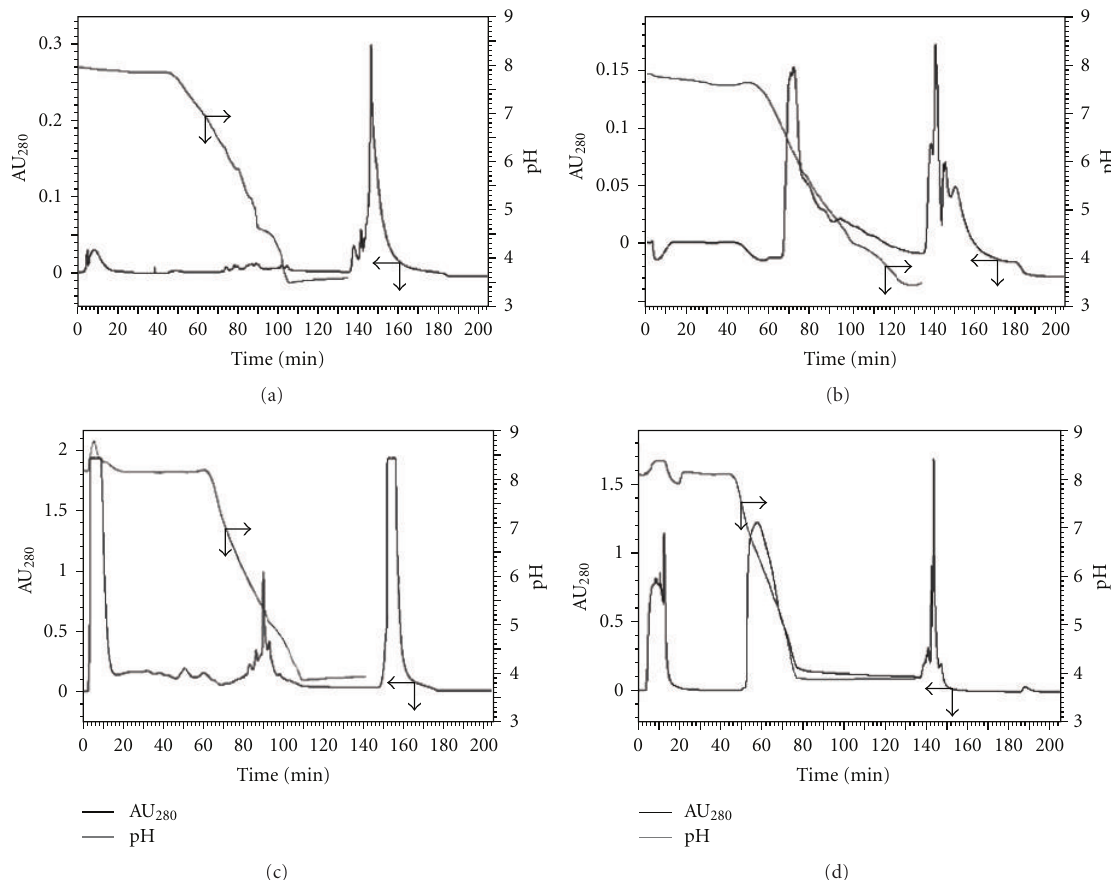
Figure 1: First-dimension elution profiles of E. coli K12 chromatofocusing analyzed on Beckman Coulter’s PF2D system over 200 min using the bu ff er provided by the manufacture (A) or bu ff ers prepared with Triton X-100 of various concentrations (0.1, 0.15, or 0.2% for B, C, and D, resp.). The elution profiles were monitored at